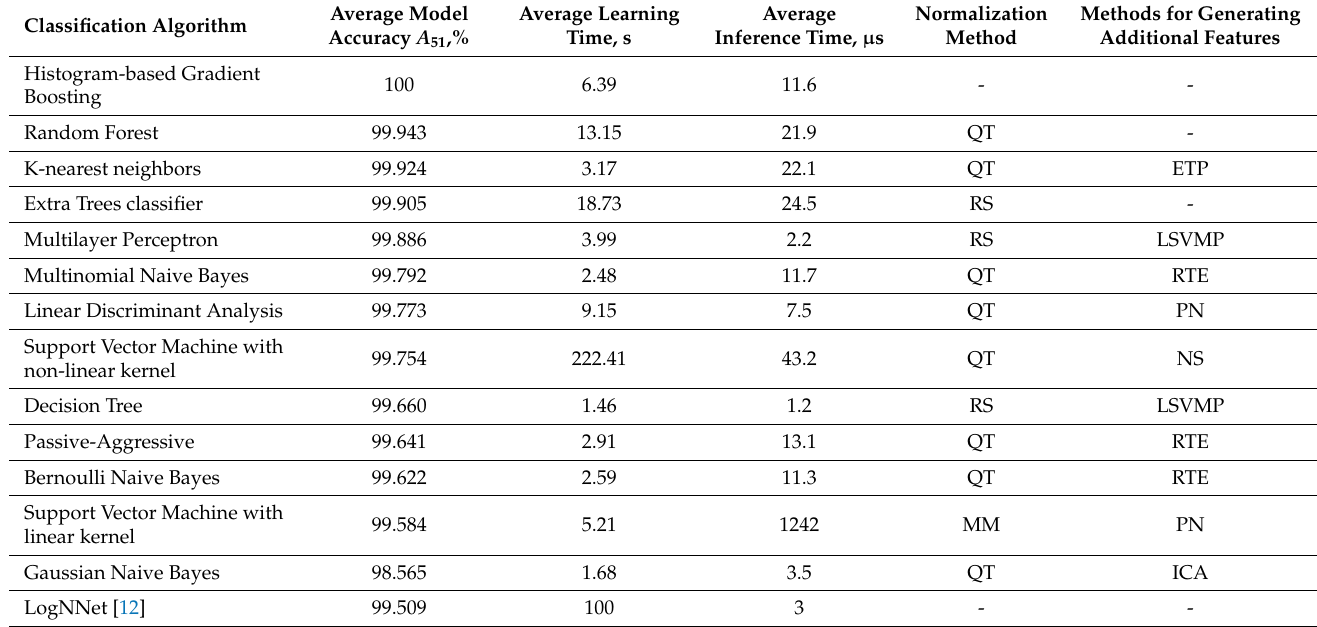
Table 5. Results of assessing the classification accuracy of machine learning models for the SARS- CoV-2-RBV1 dataset.